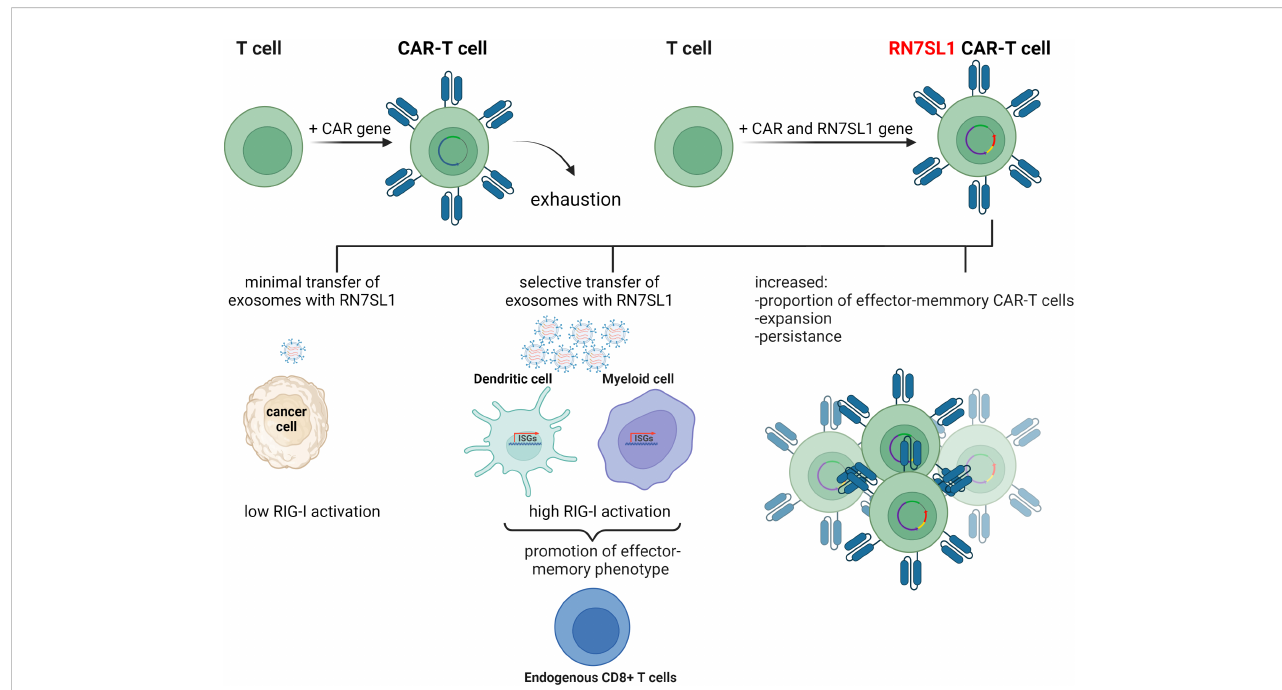
FIGURE 3 The use of endogenous RN7SL1 ncRNA to improve CAR-T cell therapy ef fi cacy. Engineered CAR-T cells transcribe transgenic RN7SL1 ncRNA together with a chimeric antigen receptor. The resulting cell-autonomous effect prevents T-cell exhaustion and increases cell expansion. In addition, excreted exosomes transport RN7SL1 to intratumor myeloid cells, such as dendritic cells, rather than cancer cells, thereby avoiding in fl ammation triggered by tumor